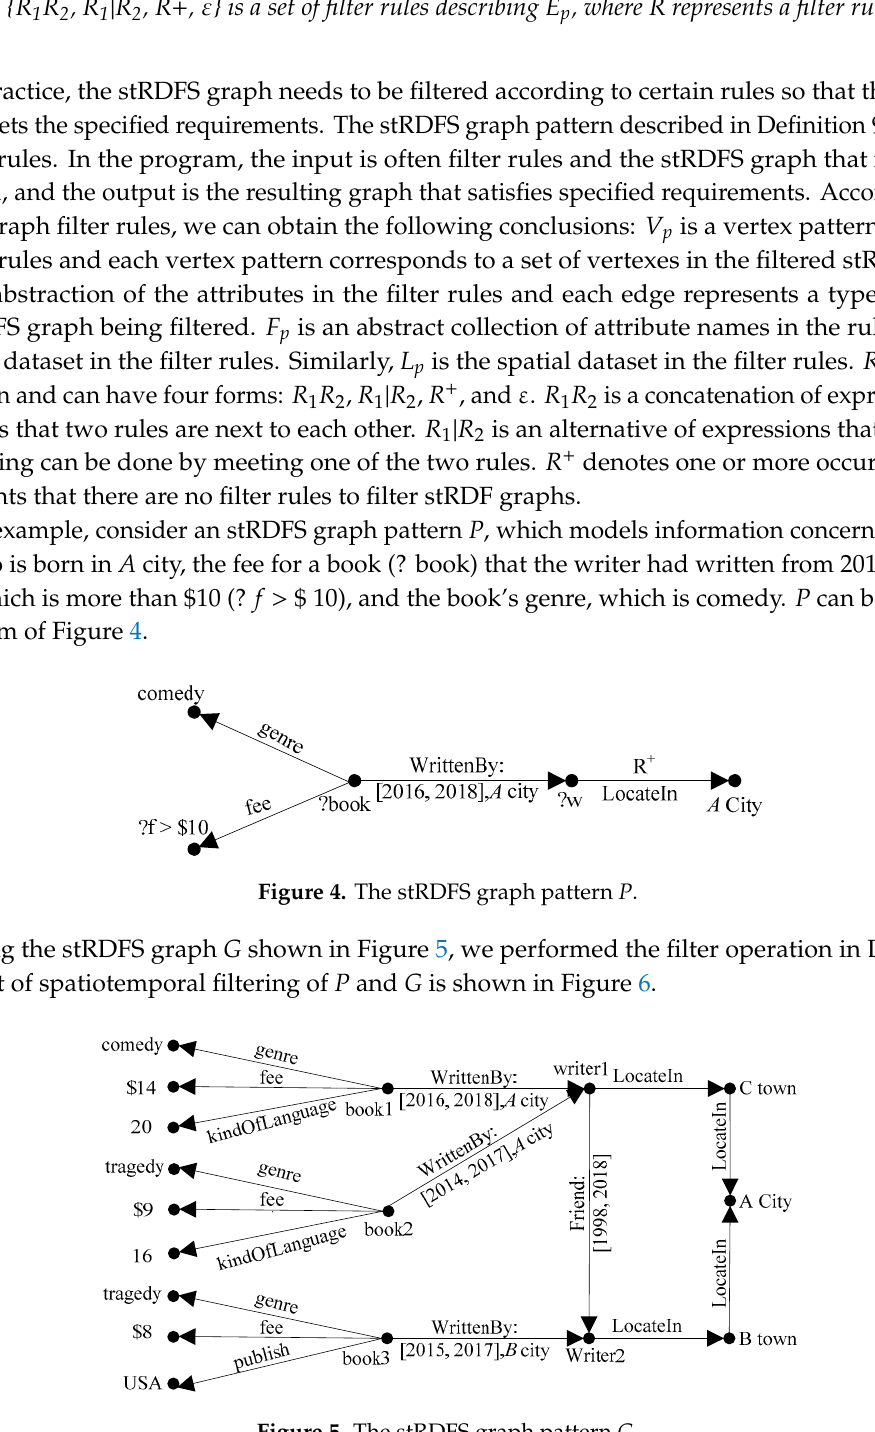
Figure 5. The stRDFS graph pattern G.